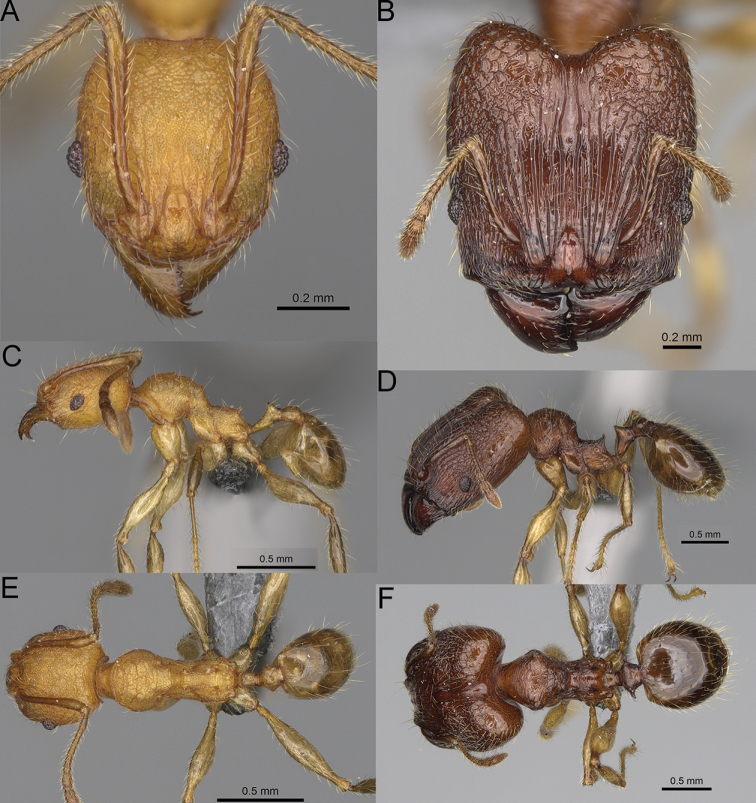
Pheidole
ankerana sp. nov., full-face view (A), profile (C), and dorsal view (E) of paratype minor worker (CASENT0274003) and full-face view (B), profile (D), and dorsal view (F) of holotype major worker (CASENT0923171).